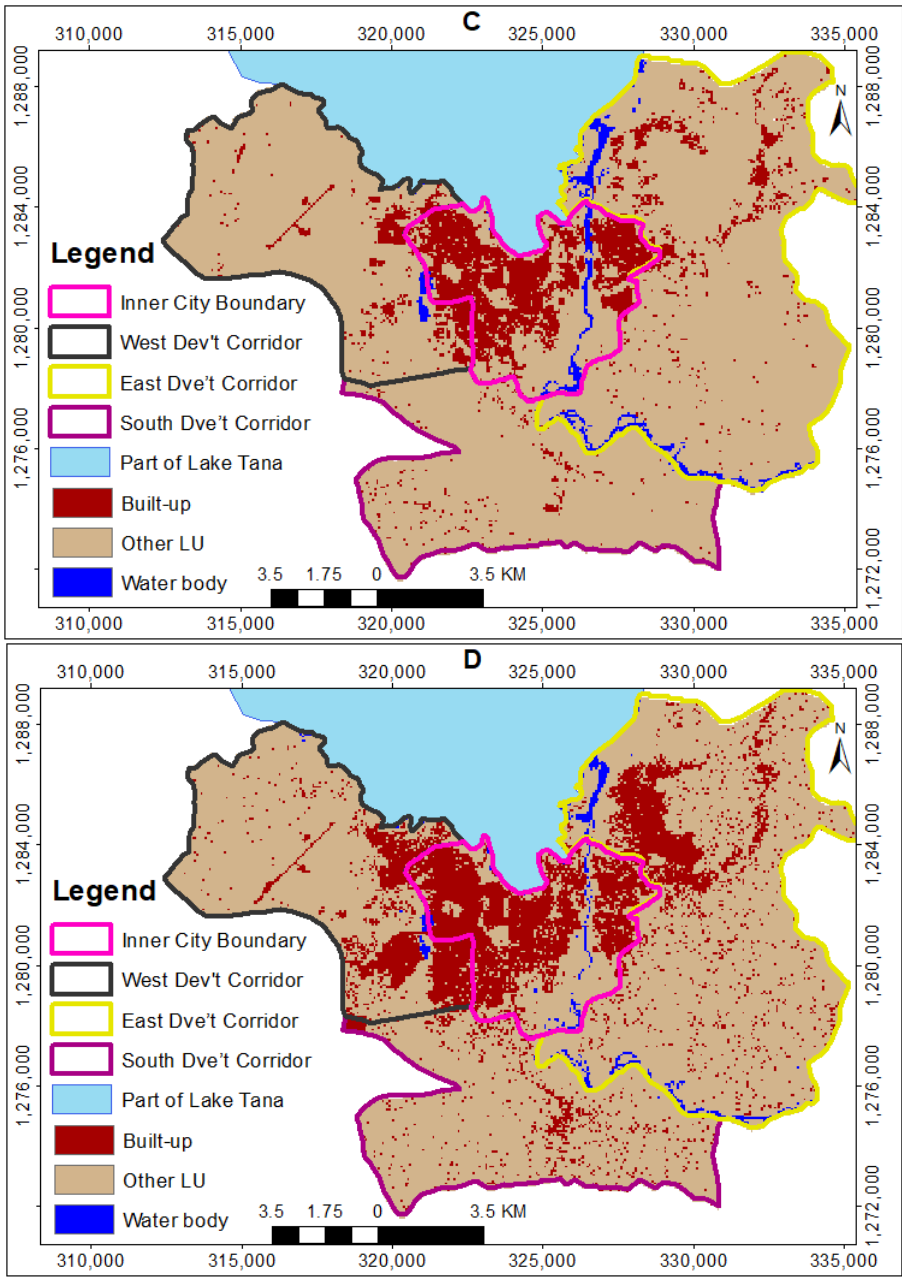
Figure 5. The spatial patterns and expansion of built-ups in each developmental corridor/peri-urban area; ( A ) (1993), ( B ) (2001), ( C ) (2011) and ( D )